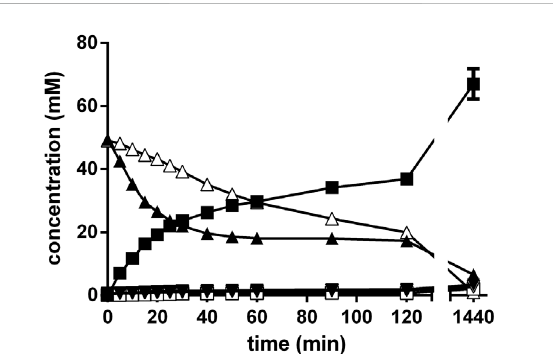
FIGURE 10 Conversion of rac -PGN by resting cells of E. coli